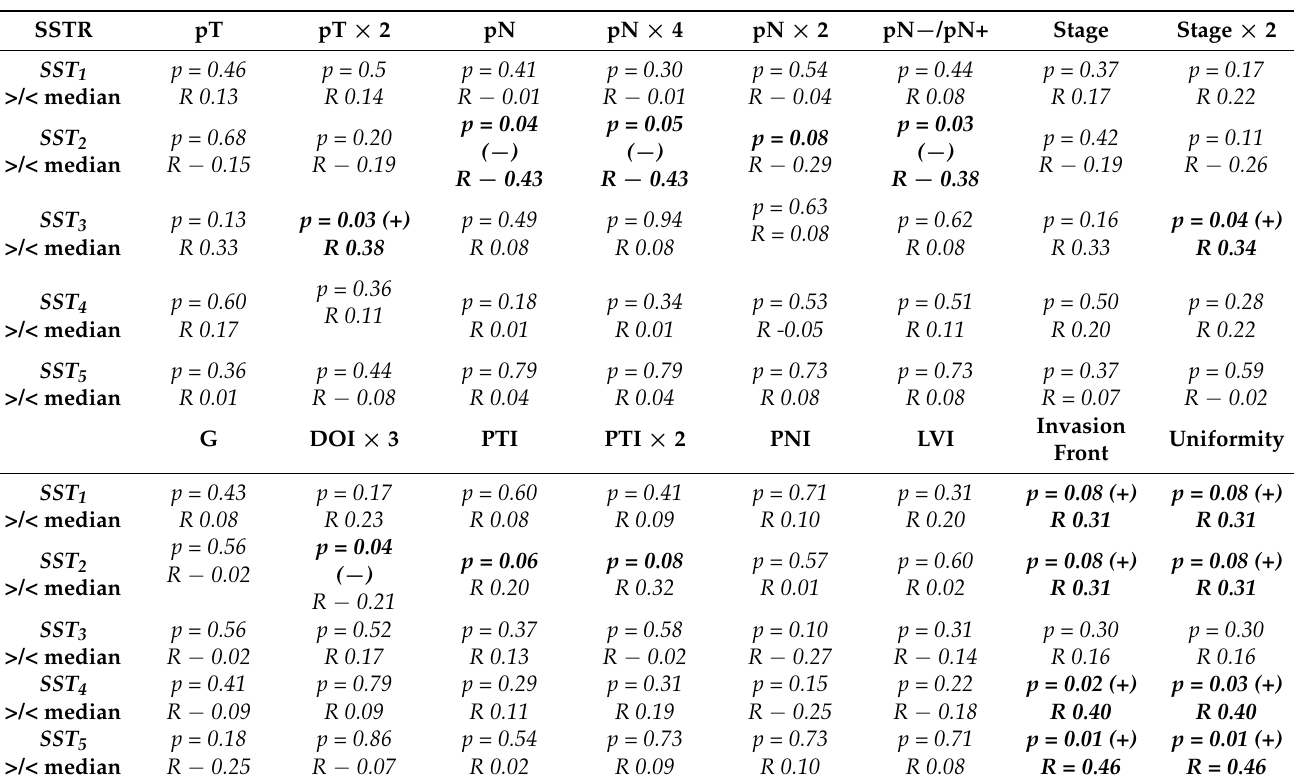
Table 3. In vivo relationship between SST-subtypes expression in OSCC and histopathological data. SSTs Categorical expression is expressed as >/< median. Chi2 or Fisher tests are used to analyze the relationship between SSTs expression and histopathological